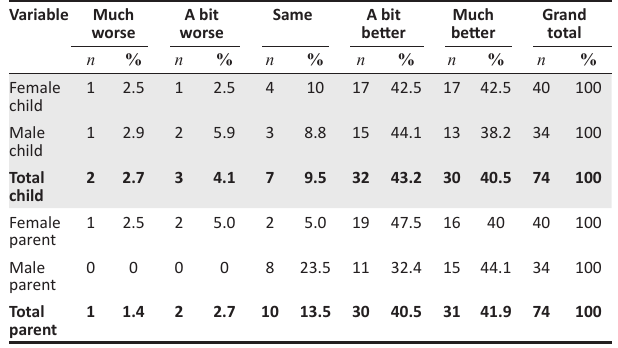
TABLE 6: Impact scale for all adolescents, and their parents.